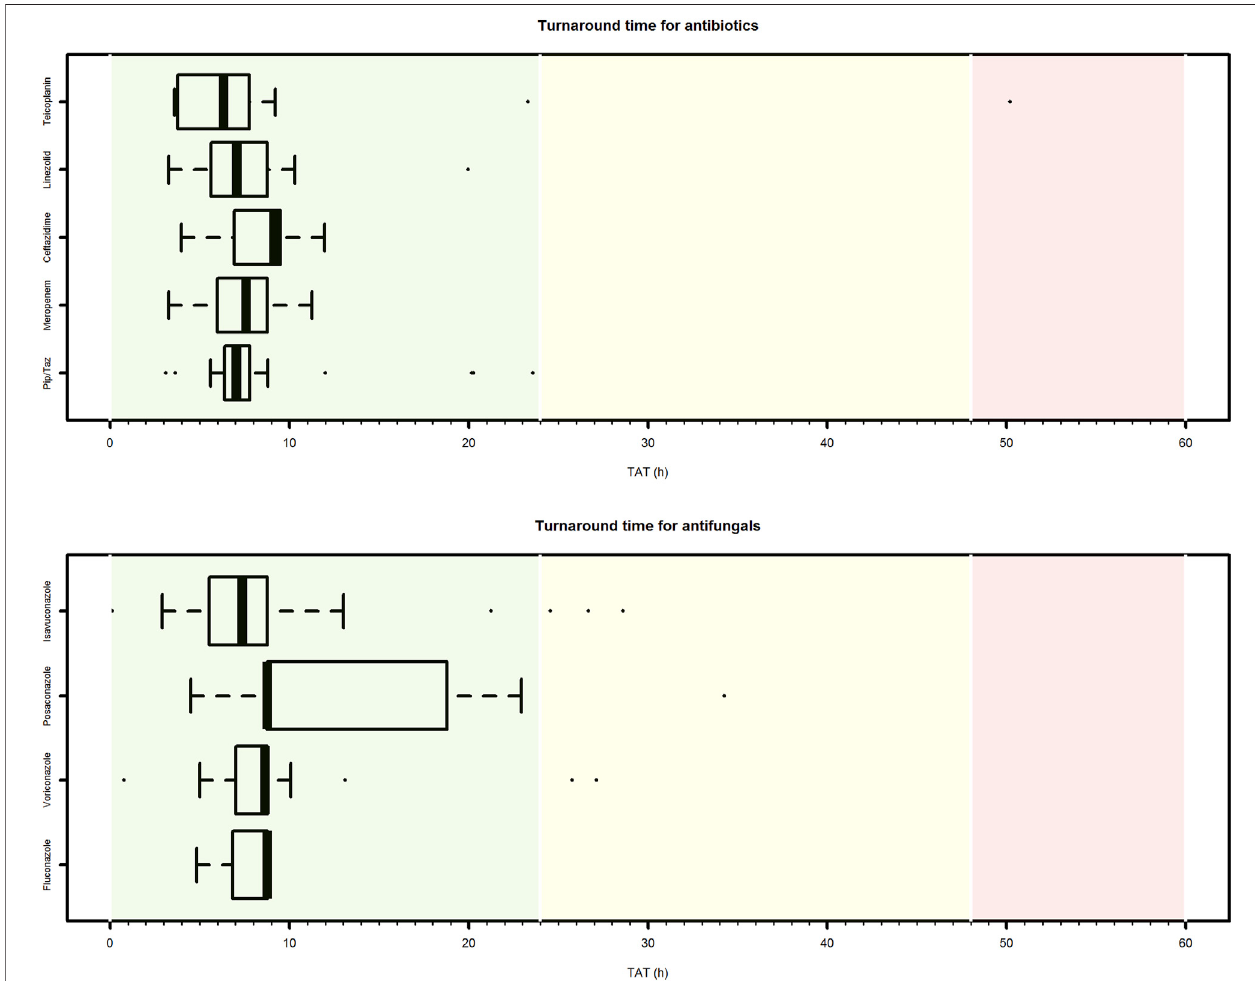
FIGURE 4 | Box plot of turnaround time of clinical pharmacological advices (CPAs) for antimicrobial dosing regimen individualization in paediatric settings. Only antibiotic or antifungal agents for which at least ten CPAs were delivered are showed. Pip/Taz, piperacillin/tazobactam.